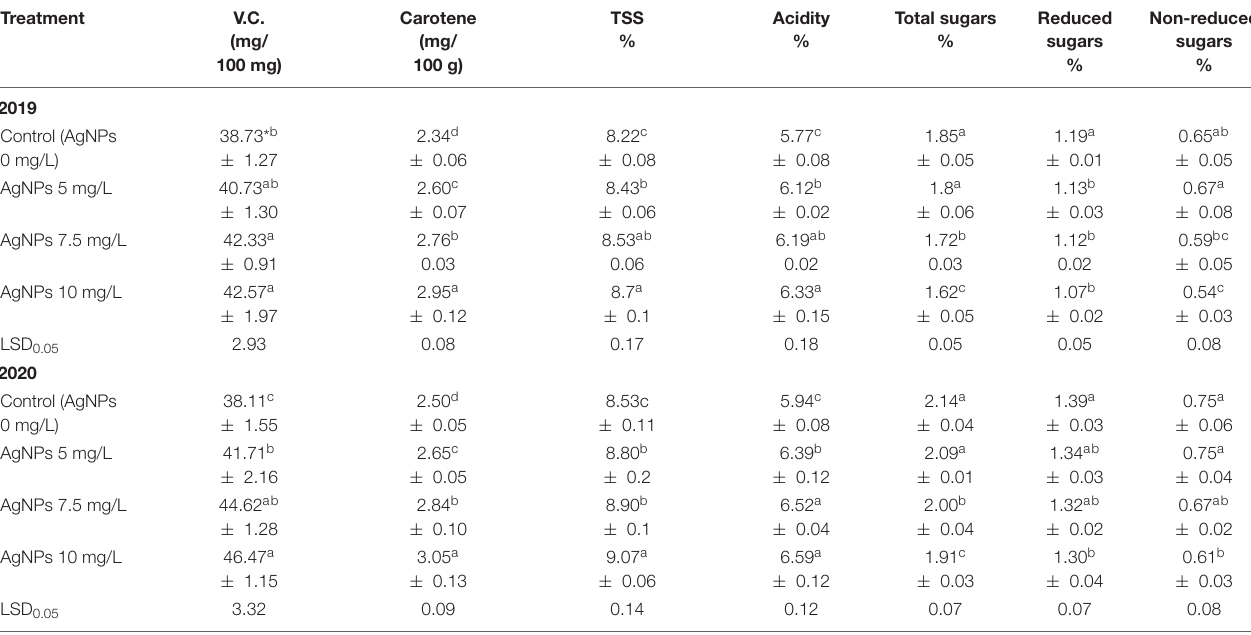
TABLE 4 | Influence of AgNPs spraying on “Eureka” lemon juice content from V.C., carotene and the percentages of TSS, acidity, total, reduced, and non-reduced sugars during 2019 and 2020 seasons. Treatment